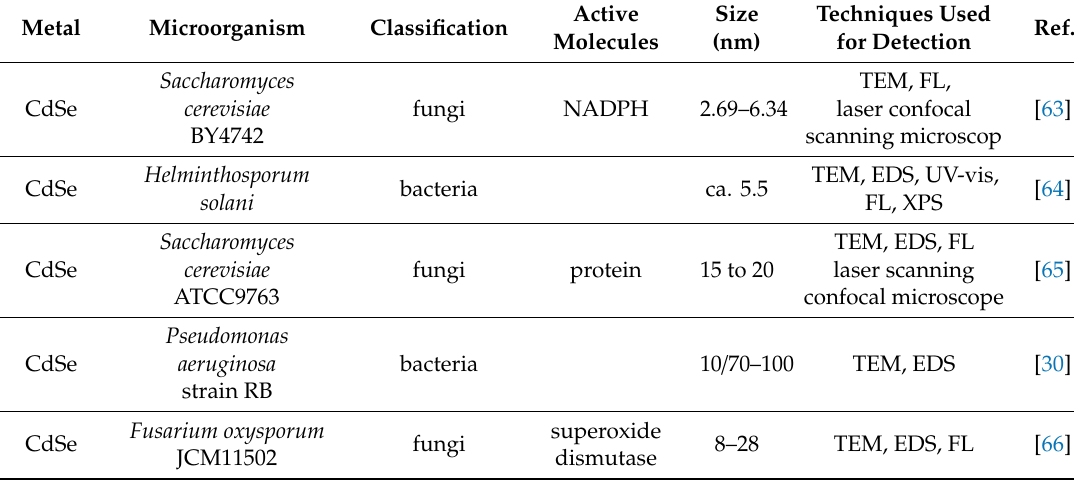
Table 4. List of microorganisms for synthesis of CdSe nanoparticles and technique for confirmation of CdSe